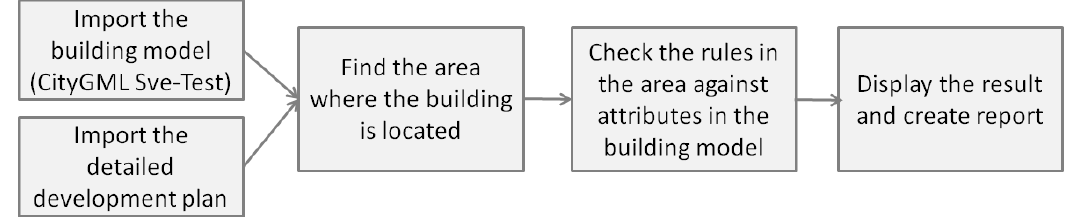
Figure 11. Workflow for the test case to study an automated check of regulations in a detailed development plan.